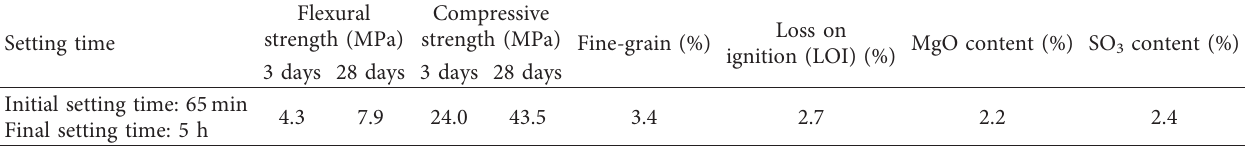
Table 1: Basic properties of P ∙ O42.5R ordinary Portland cement.